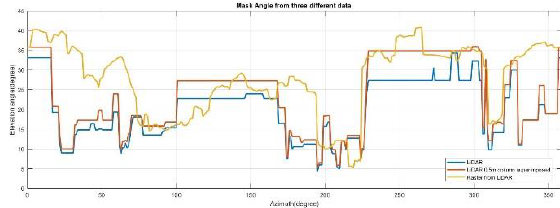
Figure 20. Point B’s mask angle from three different datasets In Figure 19 and Figure 20, the blue line indicates the original LiDAR data, the orange line the superimposed column method,